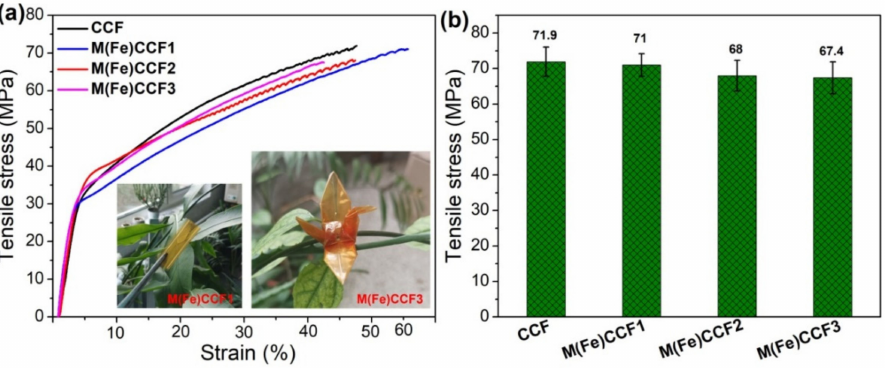
Figure 11. ( a ) The stress–strain curve of CCF and M(Fe)CCFs, the inset is a photo of M(Fe)CCF1 and M(Fe)CCF3, showing good mechanical strength and flexibility; ( b ) Tensile strength of CCF and M(Fe)CCFs.